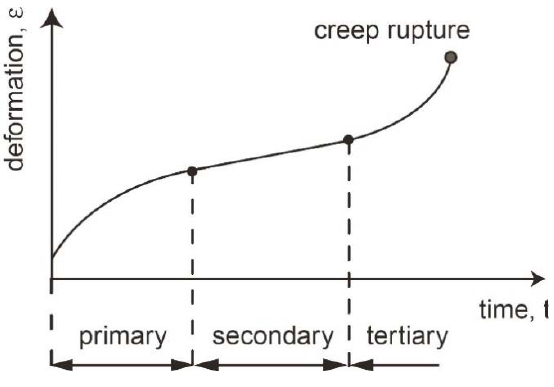
Figure 5: Creep stages based on the strain versus time